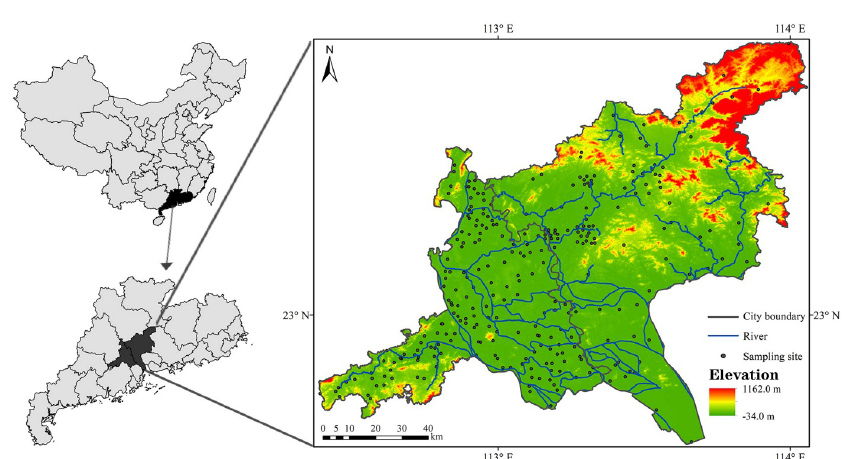
Fig 1. Location of study area and spatial distribution of sampling sites. The city boundary data are from the Department of Natural Resources of Guangdong Province. The GCS WGS 1984 coordinates is used to extract data through georeferencing and